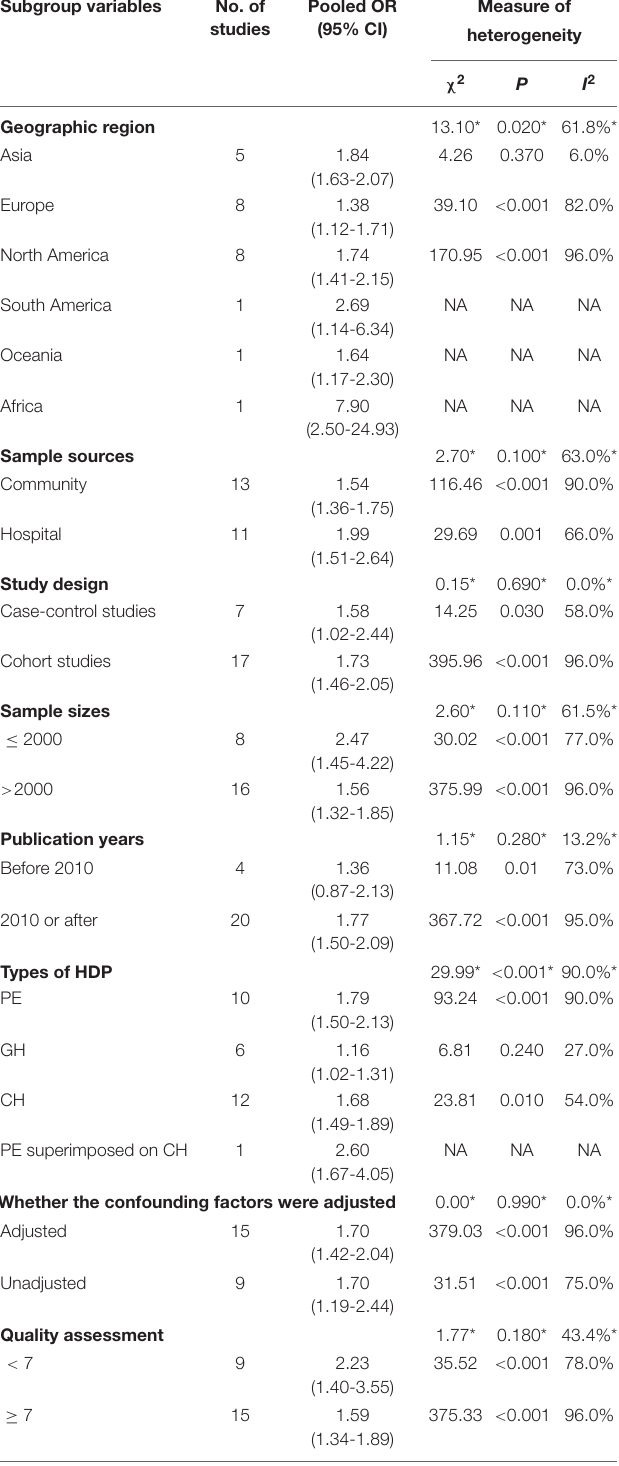
TABLE 2 | Subgroup analysis of association maternal HDP exposure and risk of congenital heart defects in offspring. Subgroup variables No. of